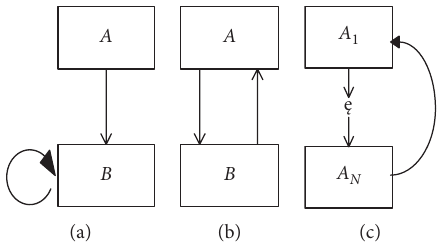
Figure 2: Conflicting relationships in the initial model. (a) Unary conflict. (b) Binary conflict. (c) N -ary